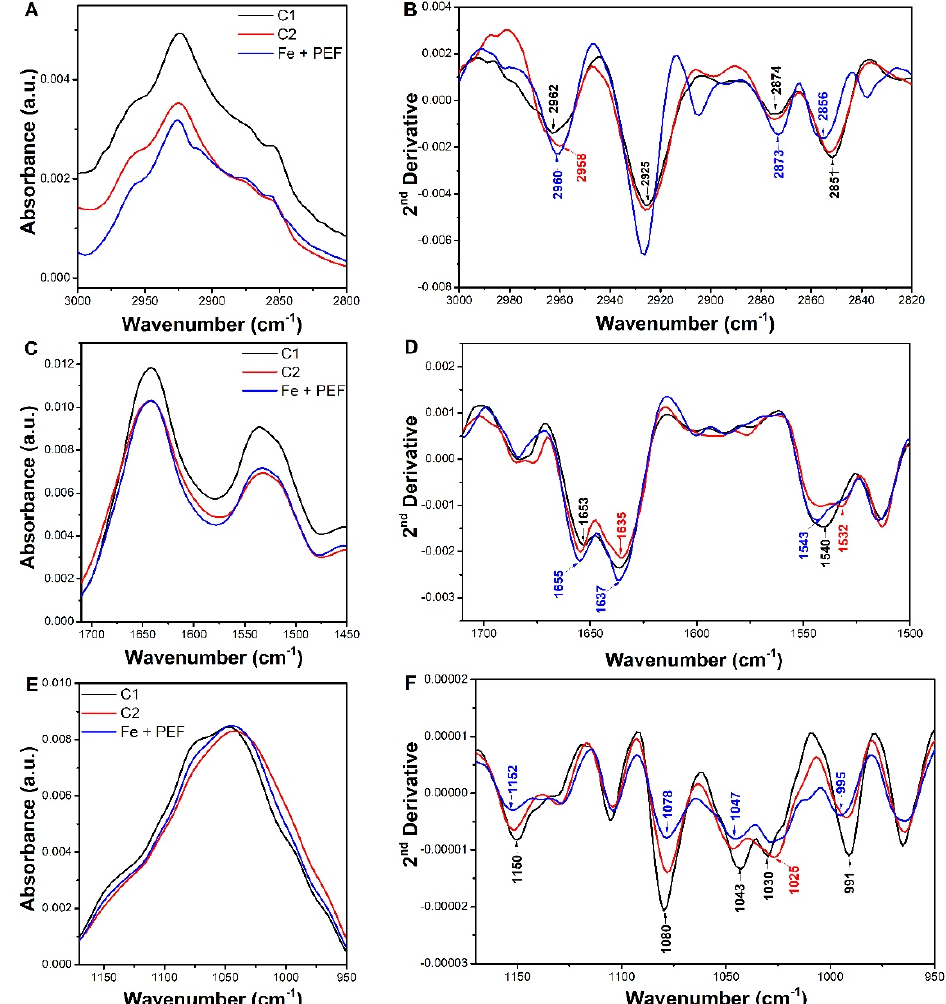
Figure 8. The ATR FTIR spectra of yeasts stained and their second derivatives in the selected ranges. ( A , B ): the region of the vibrational modes mainly due to the asymmetric and symmetric stretching vibrations of CH 2 and CH 3 methylene groups ( C , D ): the region of amide I and amide II bands; ( E , F ): the region of carbohydrates modes. The second derivative spectra have been normalized to the CH 2 band at ~2924 cm − 1 ( B ), to the amide I ( D ) while in panel F spectra have been normalized at the area under range 1180-900 cm − 1 . C1-control culture without iron added to the medium and PEF treatment (black line), C2-control culture with iron ions added to the medium (200 µ g/mL) and without PEF treatment (red line), and Fe + PEF culture with iron ions added to the medium (200 µ g/mL) and treated with PEF (ferric nitrate, voltage 1500 V, pulse width 10 µ s, treatment time 20 min, 1200 pulses, after 20 h of cultivation) (blue line).